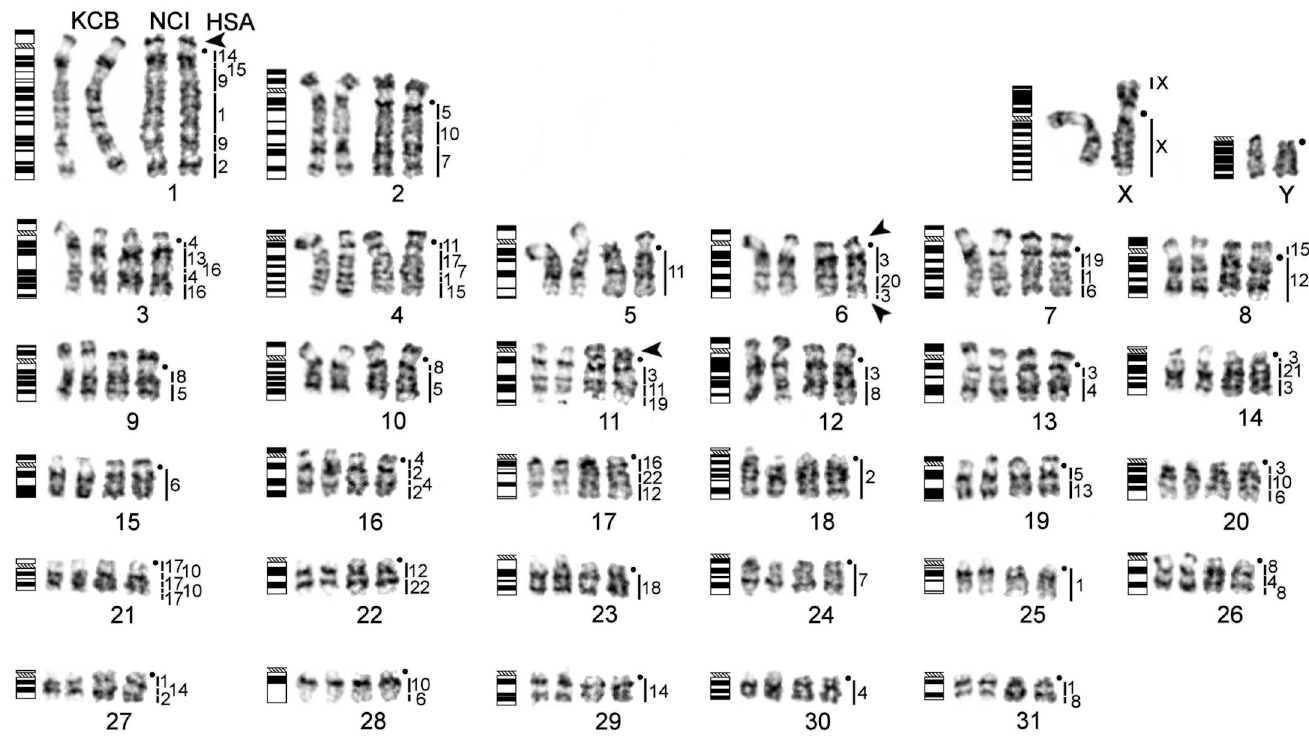
Fig 1. Idiogram and karyotype of the guinea pig with homologies to human (HSA) revealed by comparative chromosome painting. Black dots mark position of centromeres. Black triangles indicate NORs located on CPO1, CPO6 and CPO11 (see comments in the text). Each pair presented in two copies to show chromosomes with different resolution: KCB — CPO-KCB, NCI —